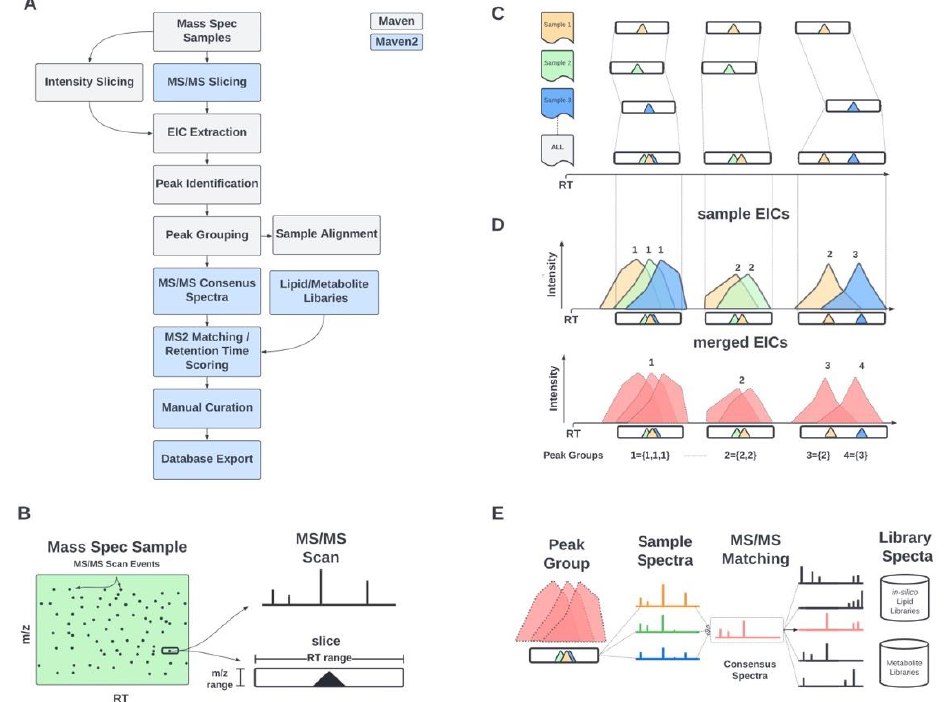
Figure 1. Overview of MS/MS-based workflow in MAVEN2. MAVEN2 implements MS/MS-based slicing, construction of consensus spectra, and spectral library matching. Outline of key steps and novel algorithmic implementations are highlighted in blue ( A ). MS/MS scans collected in LC/MS run are used as seeds for formation of “slices”—blocks in m / z and retention time (RT) space surrounding the MS/MS scan’s precursor m / z ( B ). Slices from all samples are merged based on overlaps in m / z or RT space ( C ). These merged slices are used to generate extracted ion chromatograms (EICs) and summed to form a merged EIC. Peak groups are defined by overlapping regions of intensity in merged EIC. The peaks picked from individual sample EICs are then associated with their corresponding peak groups ( D ). MS/MS Spectra corresponding to a peak group are combined to form a consensus spectrum, which is then searched against spectral libraries to identify compounds ( E ). This approach allows for annotation of peaks in samples even when no MS/MS spectra were col- lected.